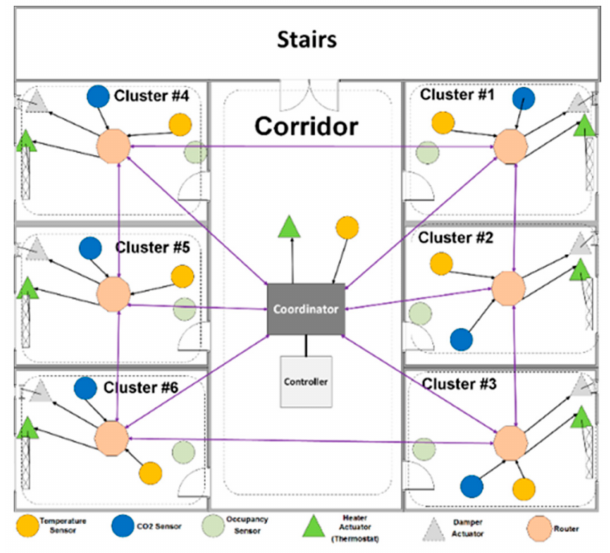
Figure 5. Network topology based on building architecture